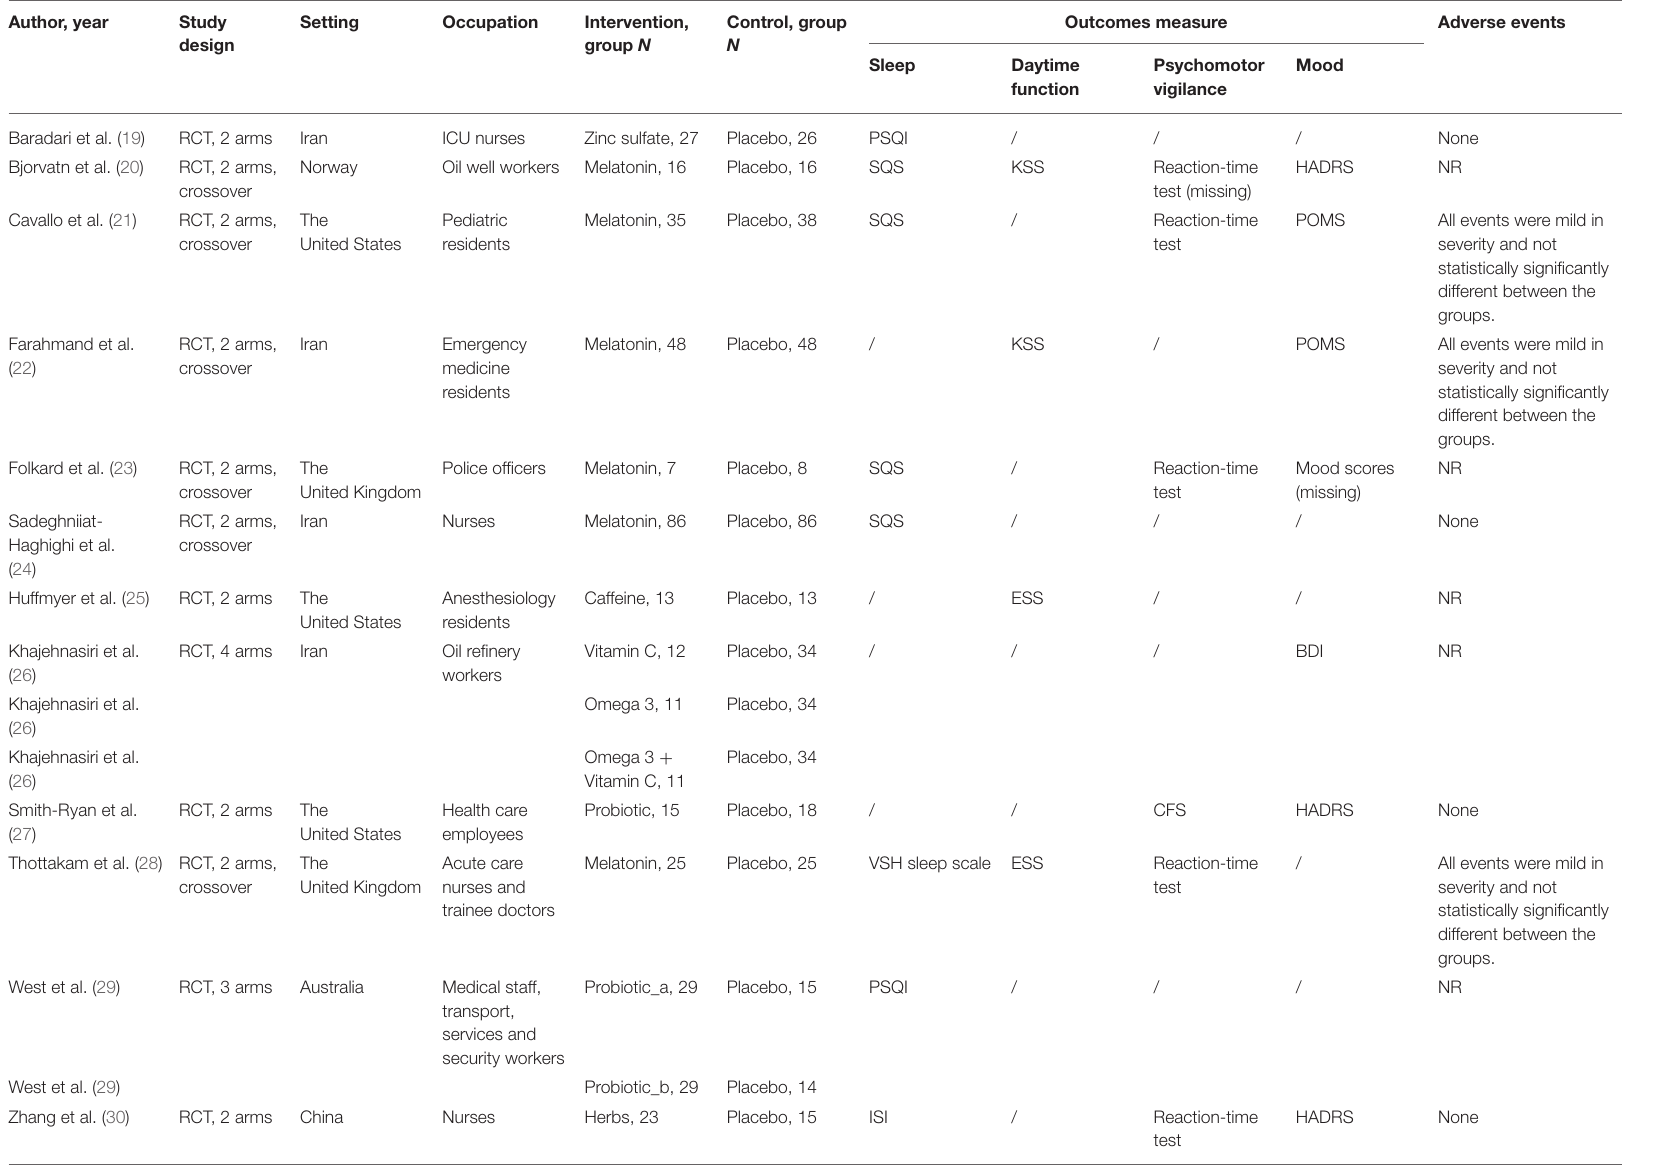
TABLE 1 | Characteristics of the included